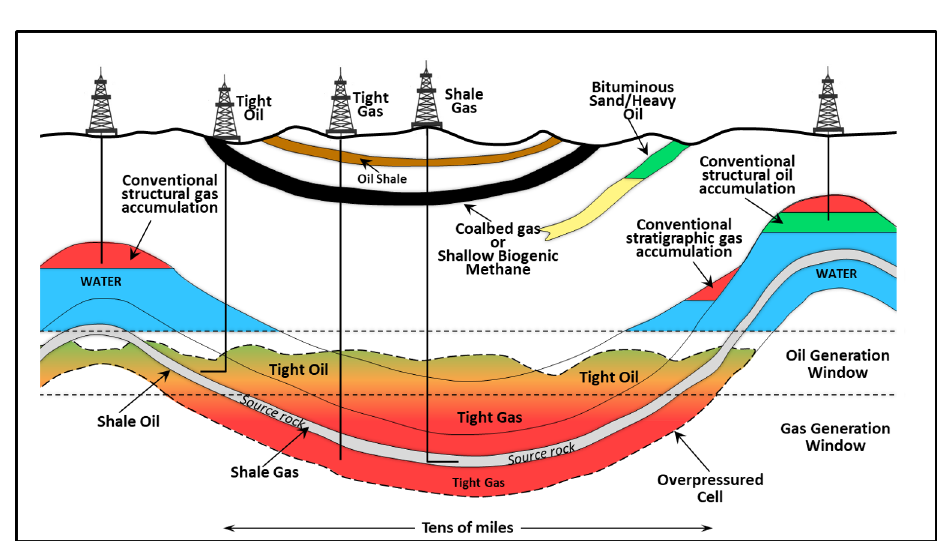
Fig. 9. – Conventional and unconventional